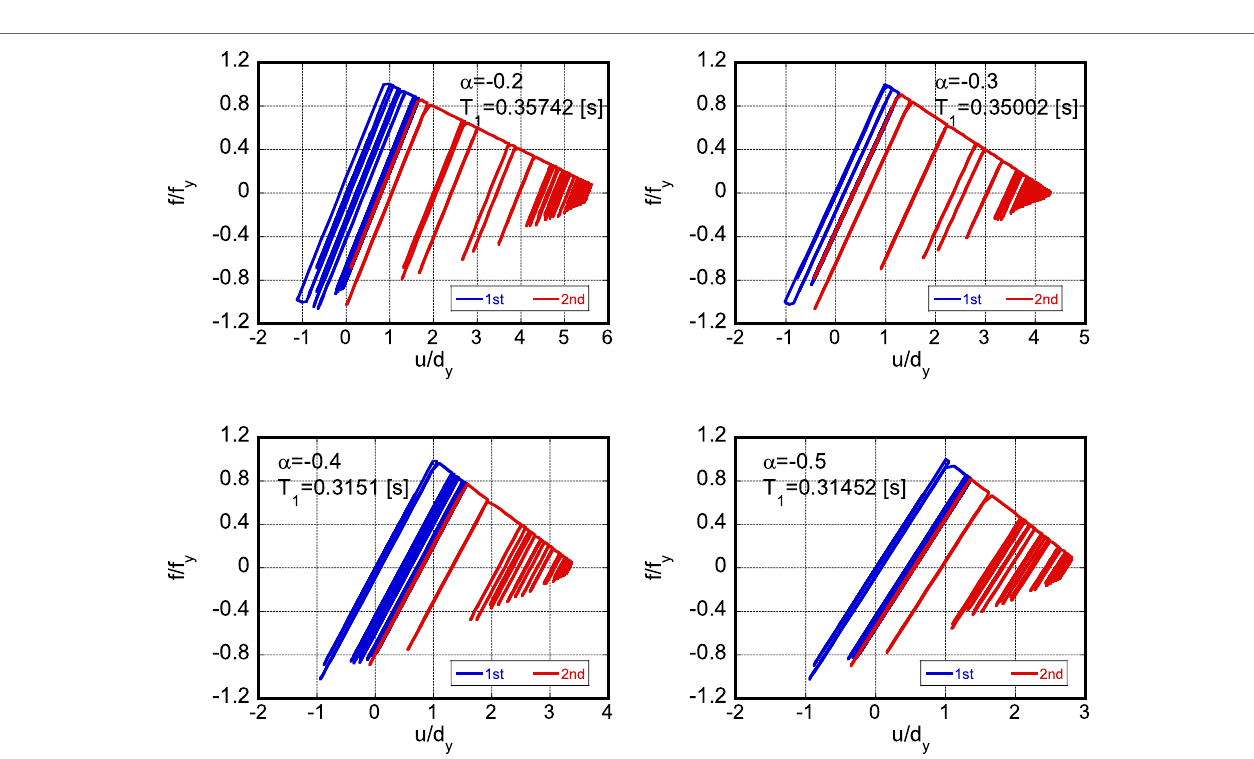
FIGURE 10 | Restoring-force characteristics of models with different second slopes under repeated 2016 Kumamoto earthquake ground motion (April 16) designed so that they just collapse after two impulses .